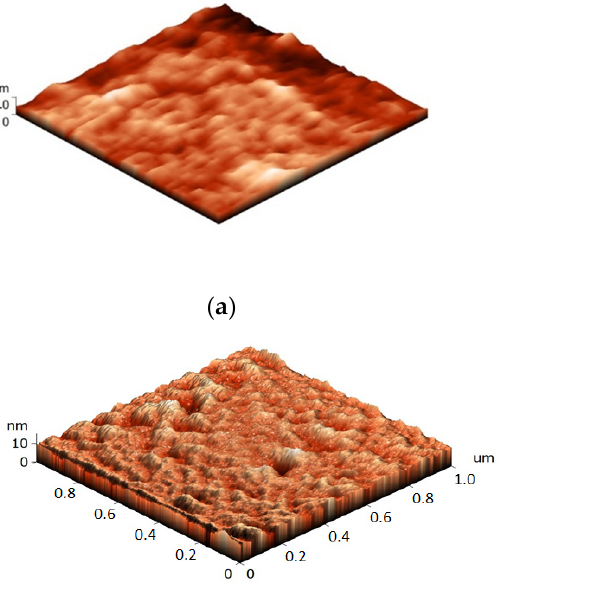
Histogram showing the width distribution of structural elements